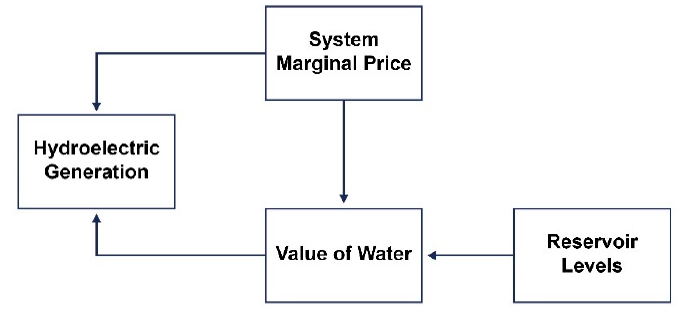
Figure 10. Components of hydroelectric production.